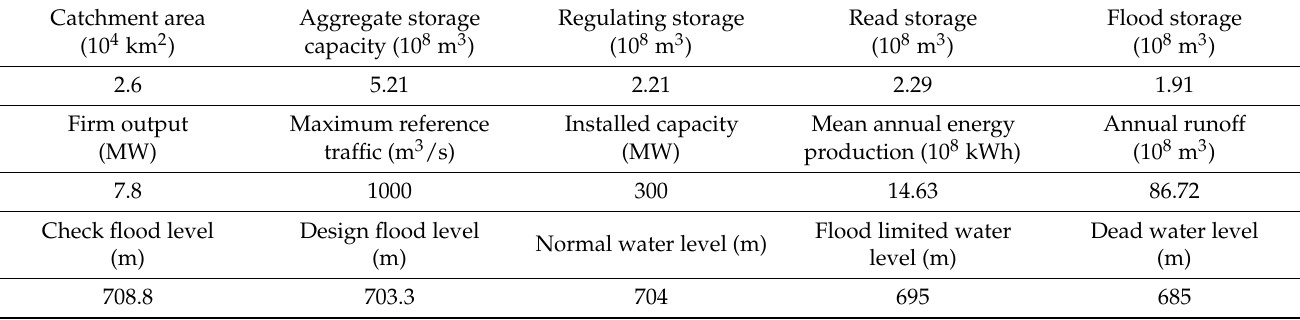
Table 2. The parameter table of the hydropower station.